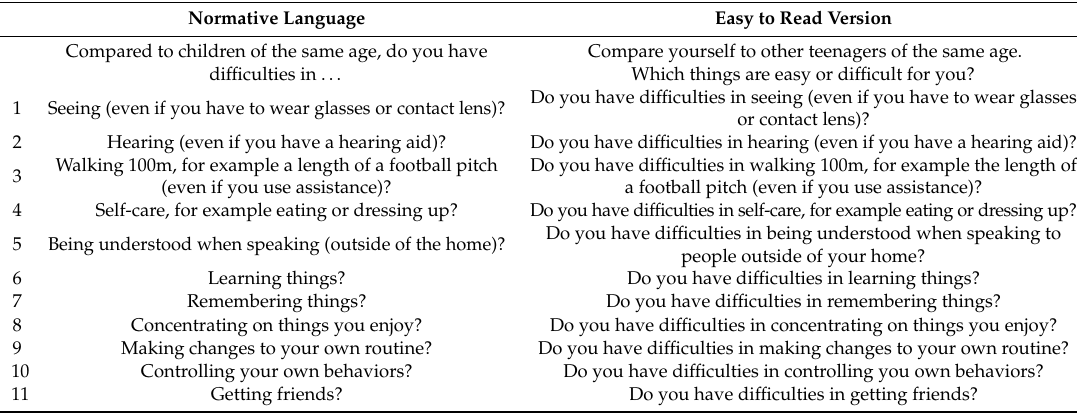
Table 1. Items of the self-report Child Functioning Module in plain and easy-to-read